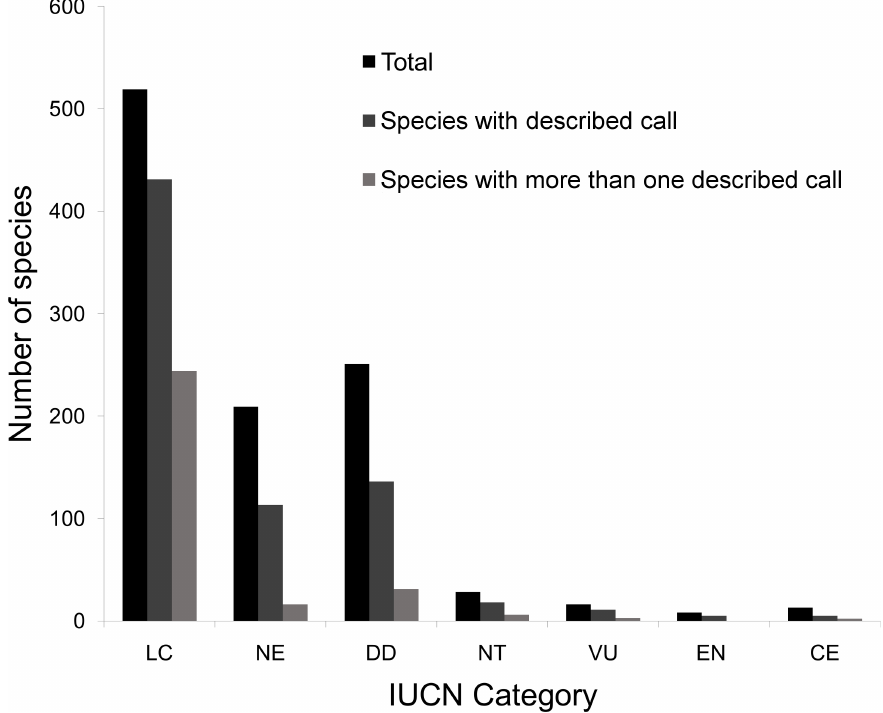
Fig 5. Number of Brazilian anuran species in each of the categories of threat of the IUCN red list with one or more published descriptions of their advertisement call.